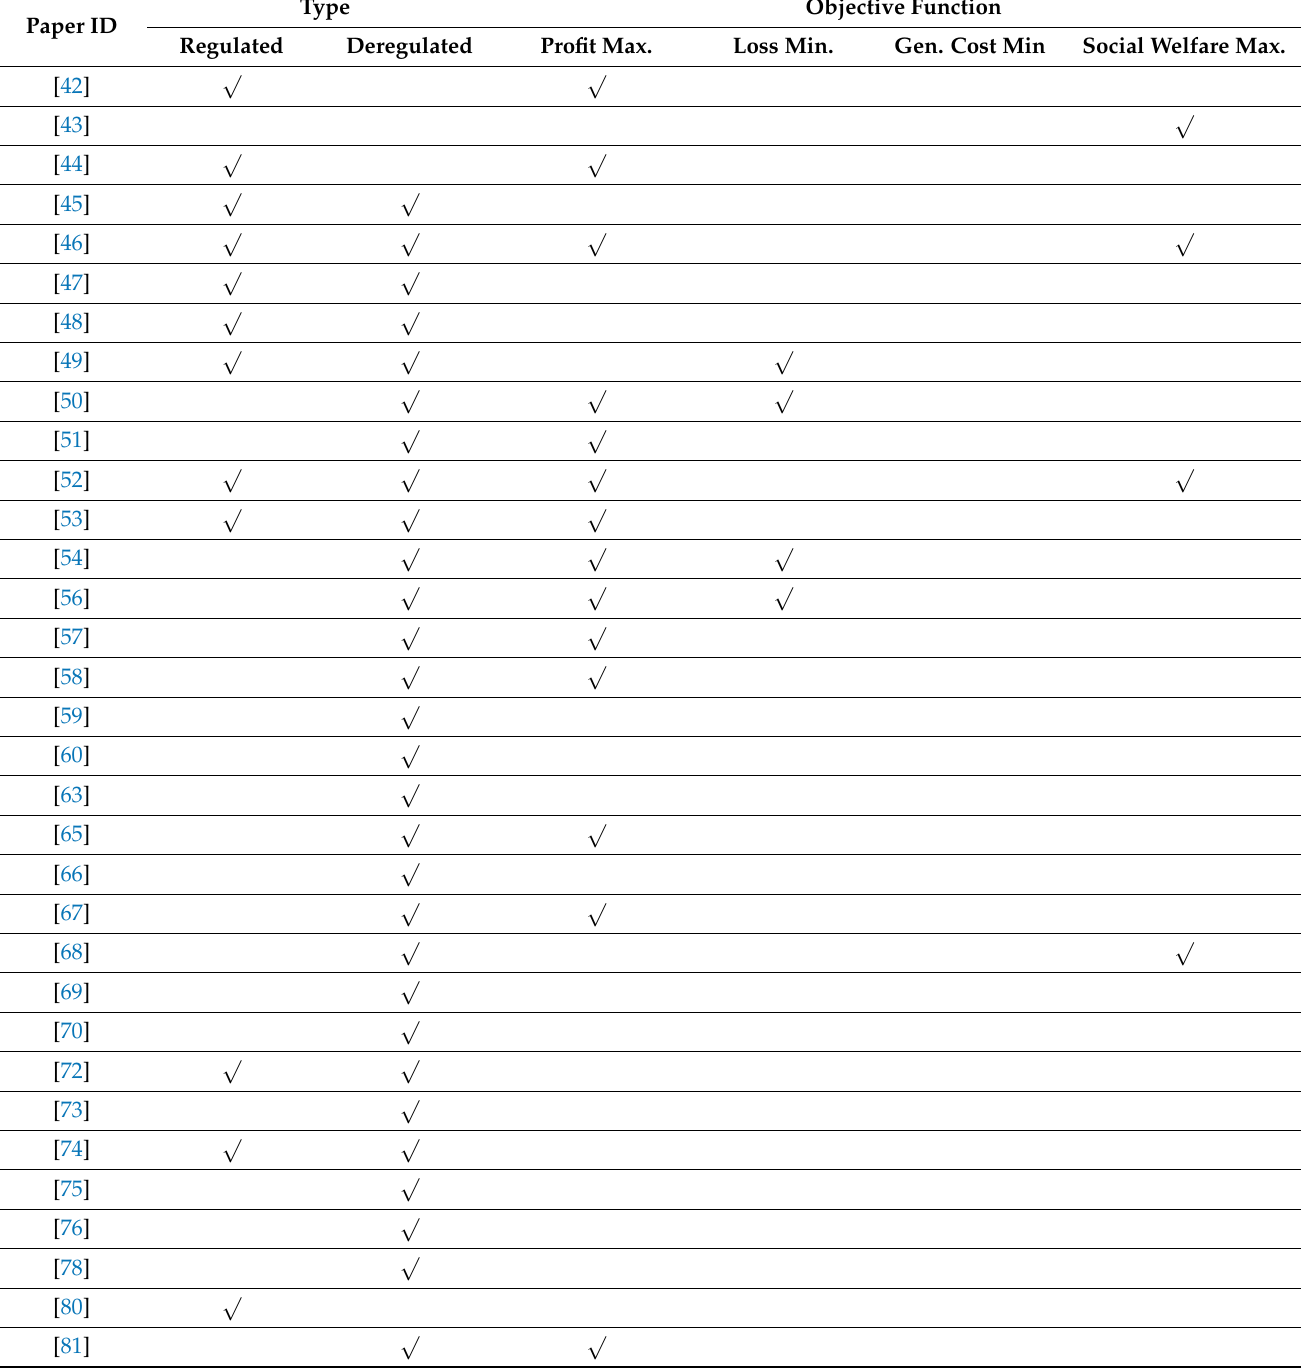
Table 1. Summary of reports for considered objective function in the